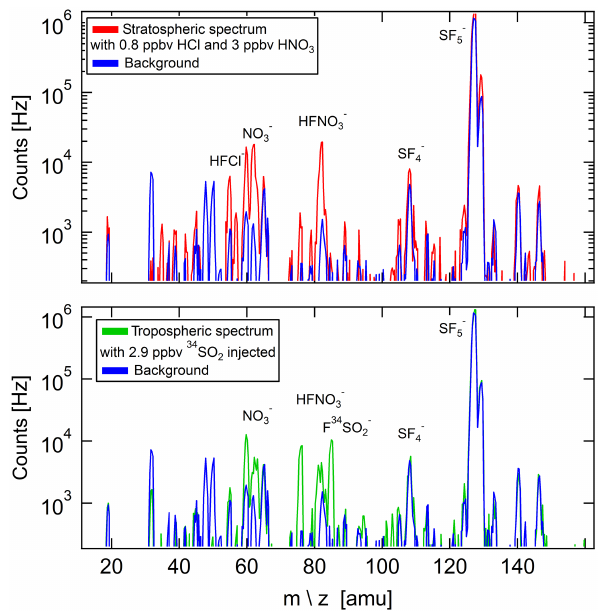
Figure 3. A spectrum of AIMS-TG obtained in stratospheric (up- per panel) and tropospheric (lower panel) air south of Cape Verde on 11 September 2012 during TACTS/ESMVal is shown. The SF − reagent ion at 127 and 129amu is most prominent. Nitric acid and hydrochloric acid with their respective ions (HFNO − HFCl − ( m/z 55 and 57)) are enhanced in the stratosphere (upper panel). The isotopically labeled SO 2 is detected as the F 34 SO − ion ( m/z = 85amu) (lower panel). At m/z 146 small amounts of SF − are also present. The stratospheric and tropospheric spectra 6 are compared to a background spectrum taken while synthetic air was introduced in the inlet